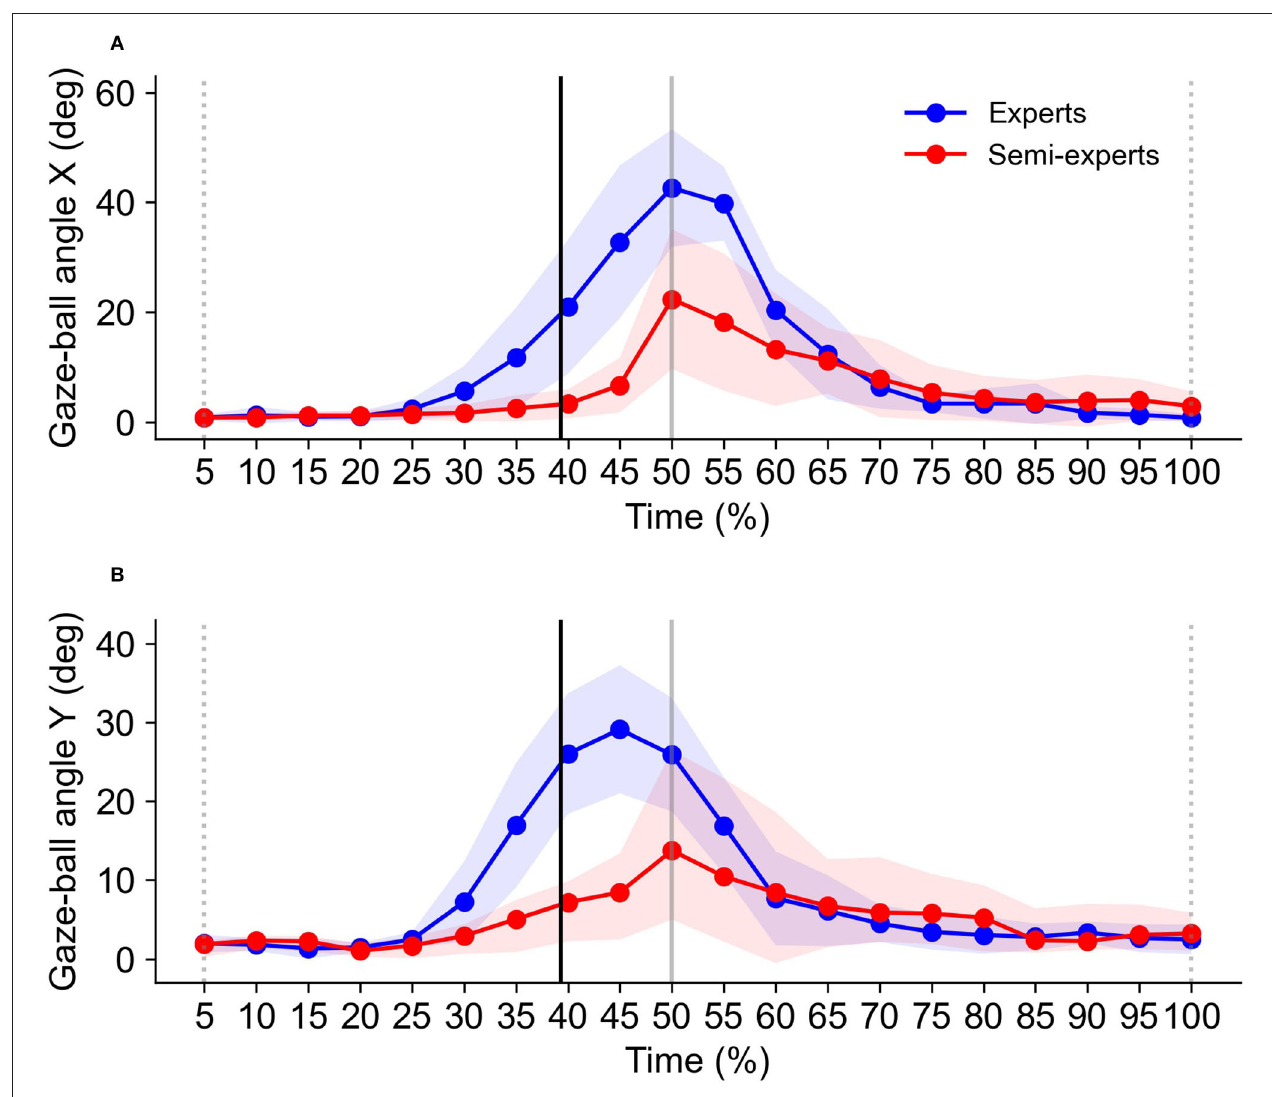
FIGURE 2 | Typical waveform patterns of the gaze-ball angle in X (A) and Y (B) directions. The broken gray lines indicate the time when the experimenter hits the ball, and the solid gray line indicates the time when the participant hits the ball. The solid black line indicates the mean time when the ball